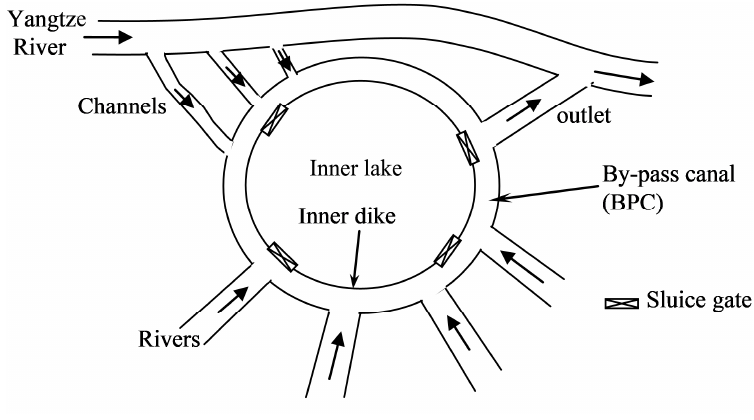
Figure 1. The schematic of the IFCS in Dongting Lake.